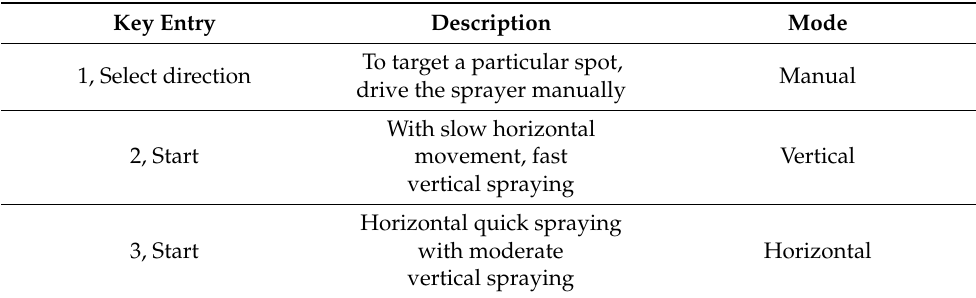
Figure 3. Spray mechanism decisions, which are based on the control of servo motors. Table 3. Sprayer Mode and